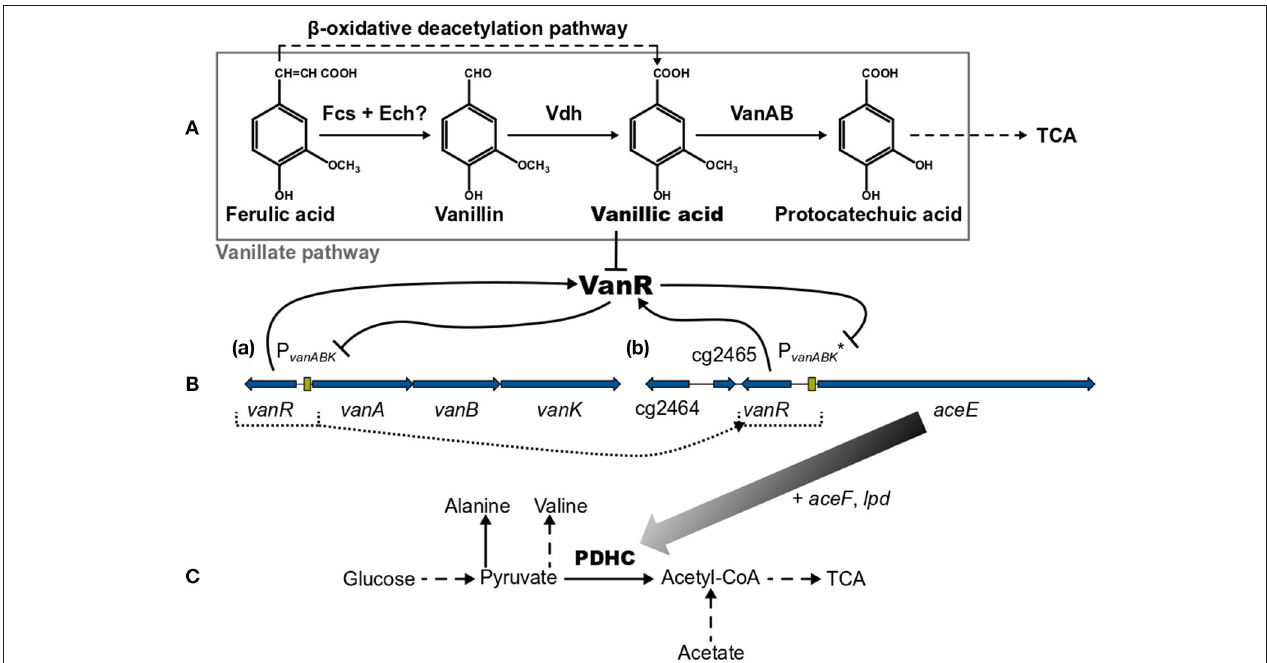
FIGURE 1 | (A) Overview of the vanillate and β -oxidative deacetylation pathways, ( B , a) the native vanR - vanABK gene cluster, ( B , b) the aceE gene under synthetic control of VanR/P vanABK * (in C. glutamicum 1 P aceE :: vanR -P vanABK *) and (C) relevant pathways around the pyruvate dehydrogenase complex (PDHC). Black arrows represent pathways or gene products and are dashed if indicating more than one reaction. Flat-headed lines point to inhibition. Blue arrows are genes and green boxes promotor regions. Color gradient of black arrow implies decreasing expression of aceE due to the utilization of phenolic compounds. Dotted lines represent the promotor exchange from P aceE to VanR/P vanABK *. (?) marks that this pathway is only predicted yet. Fcs, feruloyl-CoA synthetase; Ech, enoyl-CoA hydratase/aldolase; Vdh, vanillin dehydrogenase; VanAB, A and B subunits of vanillate demethylase encoded by vanA and vanB ; TCA, tricarboxylic acid cycle; VanR, PadR-type repressor encoded by vanR ; vanK , gene coding for vanillate transport protein VanK; cg2464 + cg2465, genes coding for hypothetical proteins; aceE , aceF , and lpd , genes coding for E1-, E2- and E3-subunits of pyruvate dehydrogenase complex (PDHC), respectively; P vanABK , promotor region of vanABK and its − 10-region-optimized derivative indicated by (*). This figure was adapted and compiled with information from diverse references ( Kalinowski et al., 2003; Merkens et al., 2005; Brinkrolf et al., 2006; Chaudhry et al., 2007; Shen et al., 2012; Pfeifer-Sancar et al., 2013; Eikmanns and Blombach, 2014; Ding et al., 2015; Morabbi Heravi et al., 2015; Kallscheuer et al., 2016; Okai et al., 2017).